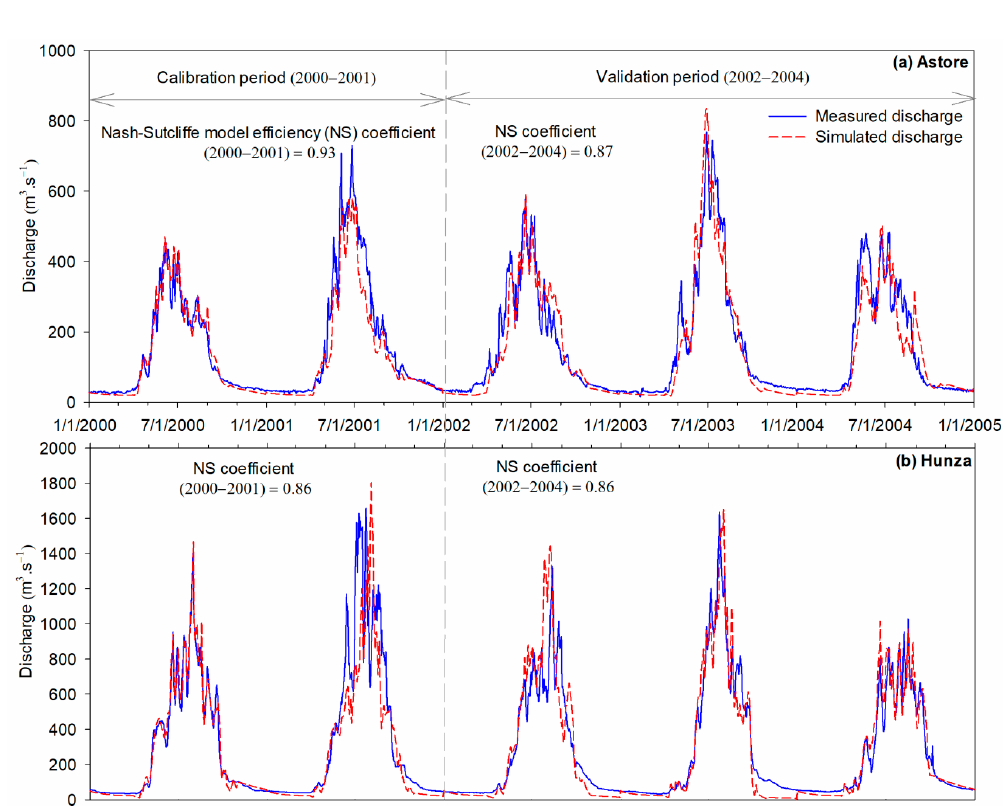
Figure 4. Evaluation of basin-wide (BW) SRM application over 2000–2004 period for ( a ) Astore and ( b ) Hunza basins.